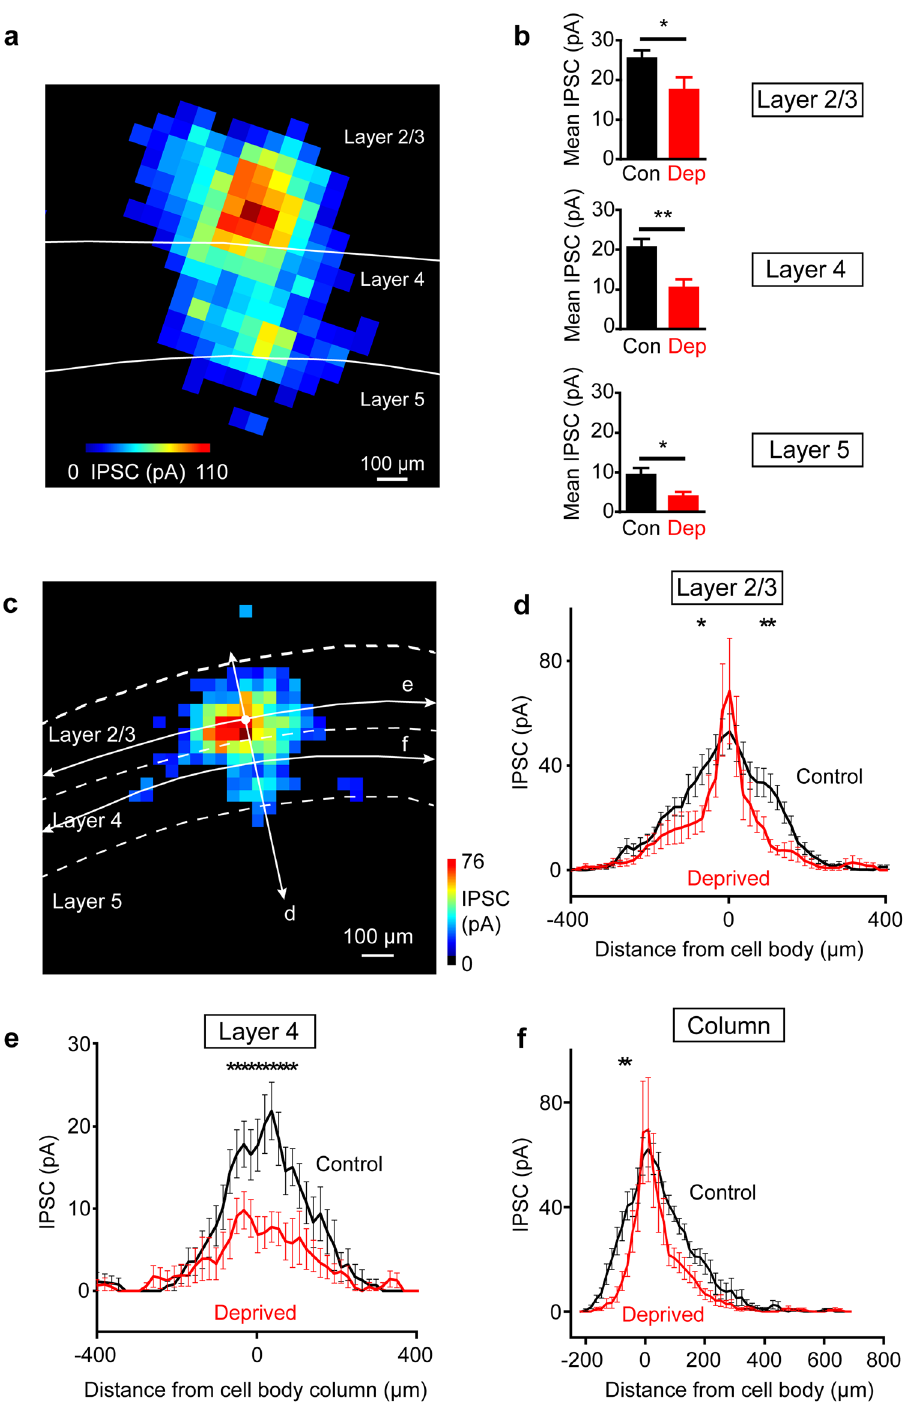
Figure 4. Chronic sensory deprivation decreased IPSC amplitudes across layers. ( a ) IPSC input map for a pyramidal cell in a control slice showing IPSC inputs from layers 2/3, 4 and 5. Layer location was determined from DIC images of slices. ( b ) Mean IPSC amplitudes were decreased for deprived slices across layers 2/3, 4 and 5. Error bars represent s.e.m. ( c ) IPSC map showing a line scan of responses along layers 2/3 and 4 (horizontal white arrows) and also along the column (vertical white arrow), with the position of the cell indicated by a white dot. ( d ) Averaged line scan of responses from IPSC maps showing that chronic deprivation narrowed the range of IPSC responses along layer 2/3 with the cell body as the reference point. Error bars represent s.e.m. (n = 14 cells each for controls and deprived, corresponding to 12 animals for control and 11 animals for deprived). Two-way ANOVA was done for the line scan with Bonferroni post-hoc tests indicating a significant effect of deprivation on IPSC responses p < 0.0001. ( e ) Averaged line scan of responses from IPSC maps showing that chronic deprivation also decreased the amplitude of IPSC responses along layer 4 with increasing distance from the center, with the position of the cell body column as the reference point. Error bars represent s.e.m. (n =